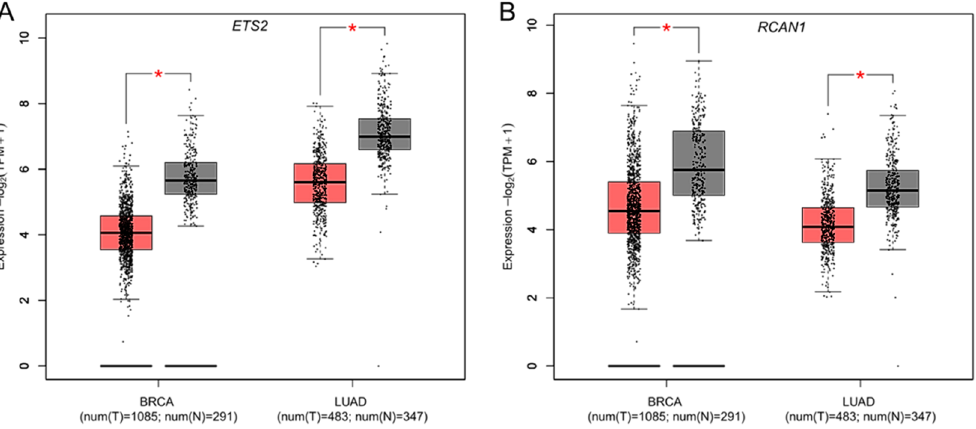
Figure 3. Differential expression of DSCR genes in breast and lung cancers. Boxplots represent mRNA expression of ( A ) ETS2 and ( B ) RCAN1 in breast and lung cancers. Red box: tumor samples, black box: normal samples, BRCA: breast invasive carcinoma, LUAD: lung adenocarcinoma, T: tumor, N: normal, * p value < 0.01, |Log2FC| > 1.